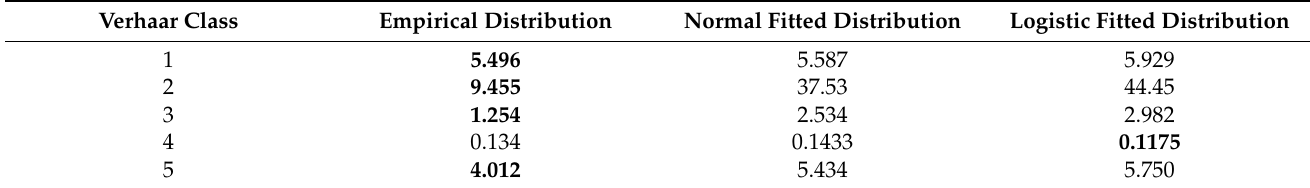
Table 1. The eco-Threshold of Toxicological Concerns (TTCs) obtained by the described approach. Bold values highlight the lower value of each subset. Values are expressed as